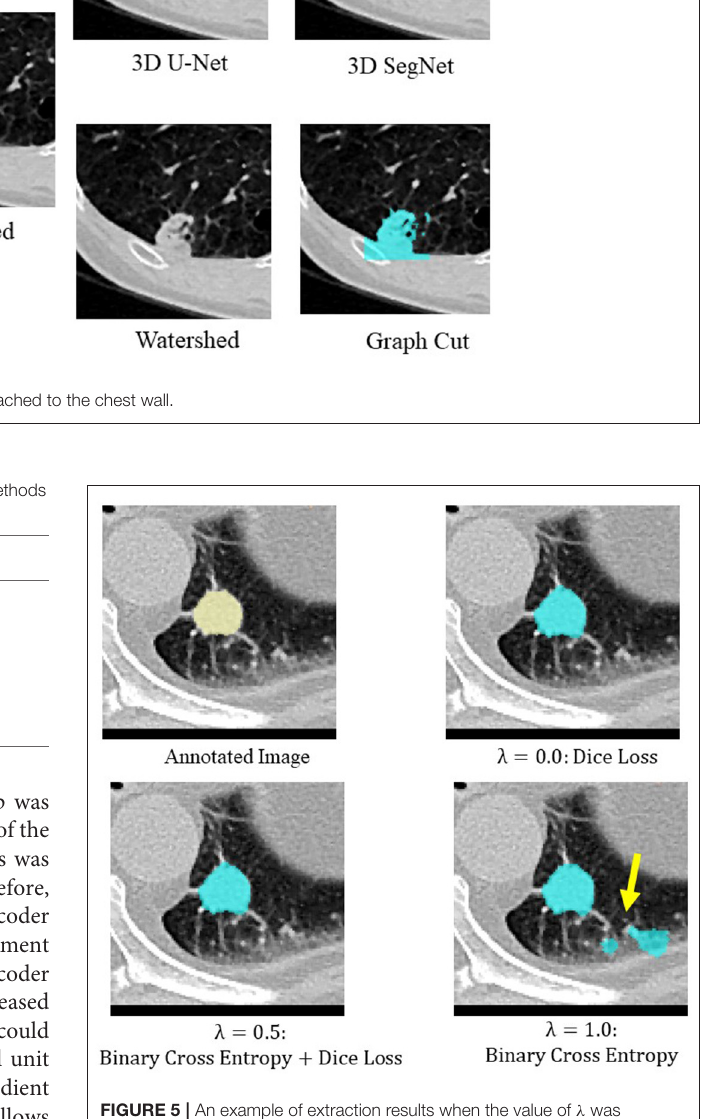
FIGURE 5 | An example of extraction results when the value of λ was changed. Under-extraction was observed when only Dice loss was used as the loss function ( λ =